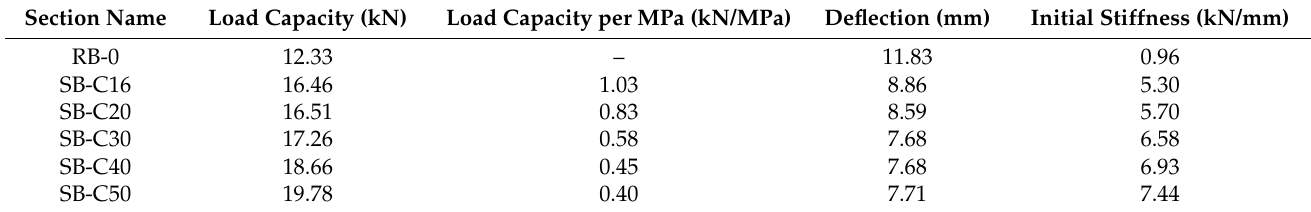
Table 7. Different Concrete Strengths